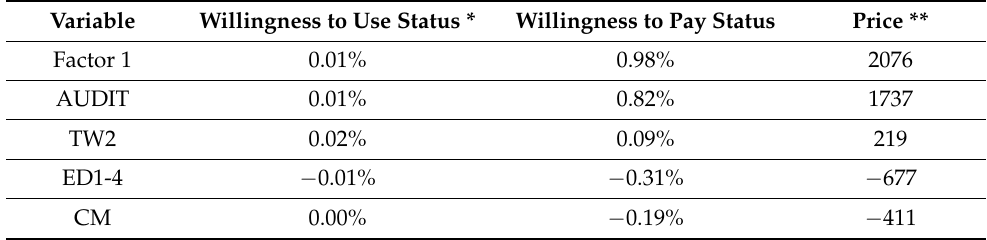
Table 14. Double-hurdle marginal probability results of drunk motorbike